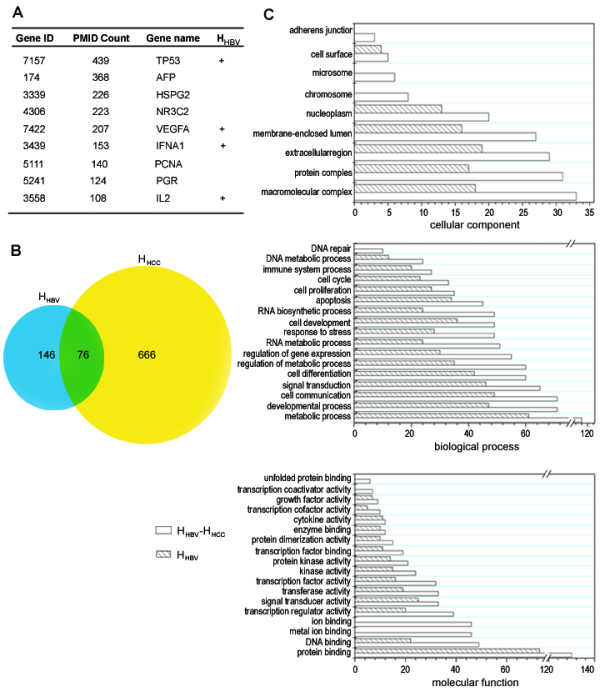
Analysis of the relationship between HHCC and HHBV. (A) Gene list of top nine HHCC. (B) Overlap between HHCC and HHBV. The blue area corresponds to HHBV; the yellow area, to HHCC: and the green area, to HHBV-HHCC. (C) Gene Ontology analysis of HHBV and HHBV-HHCC.